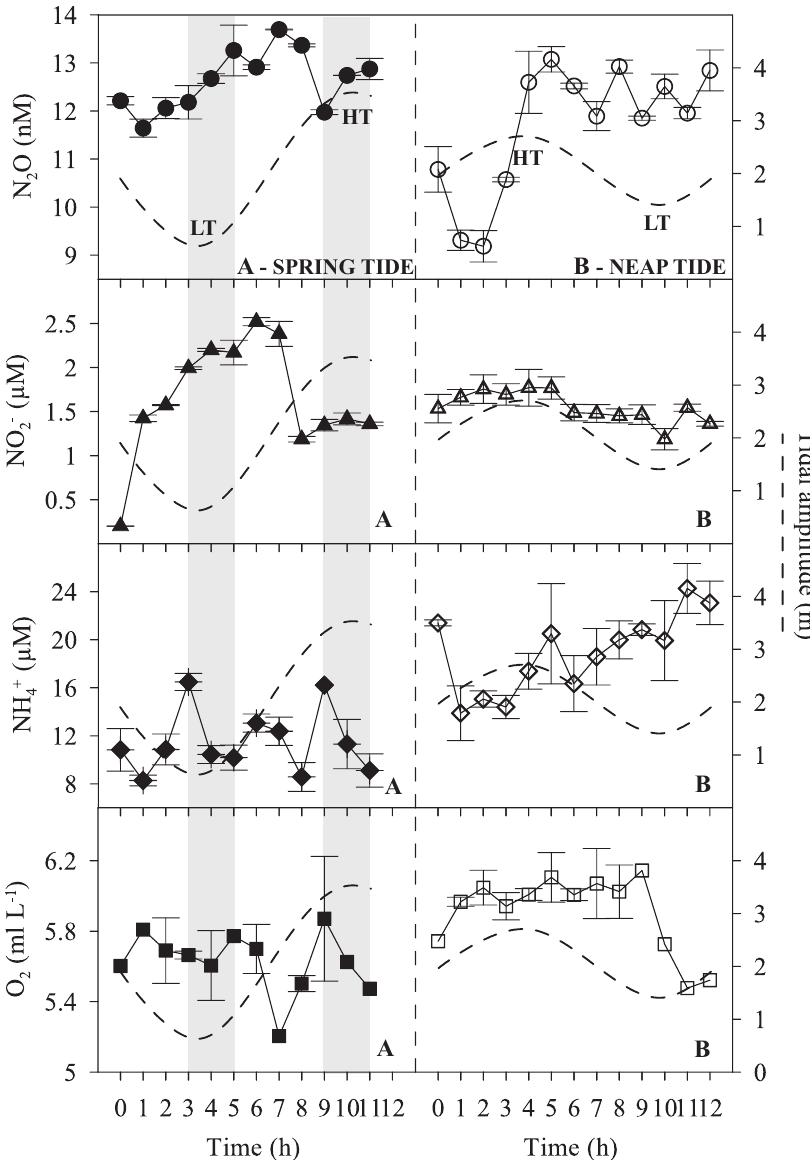
Fig . 5. – Variability of dissolved nitrous oxide (N